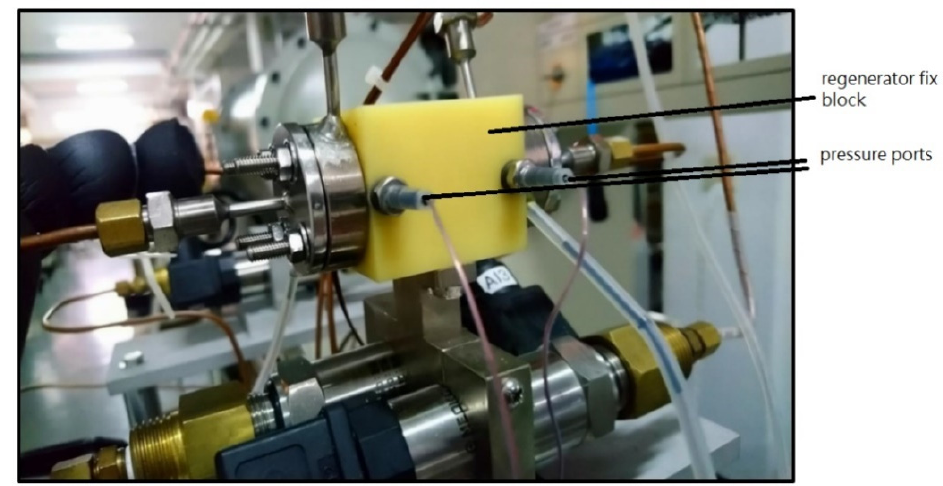
Figure 3. Regenerator fix block.